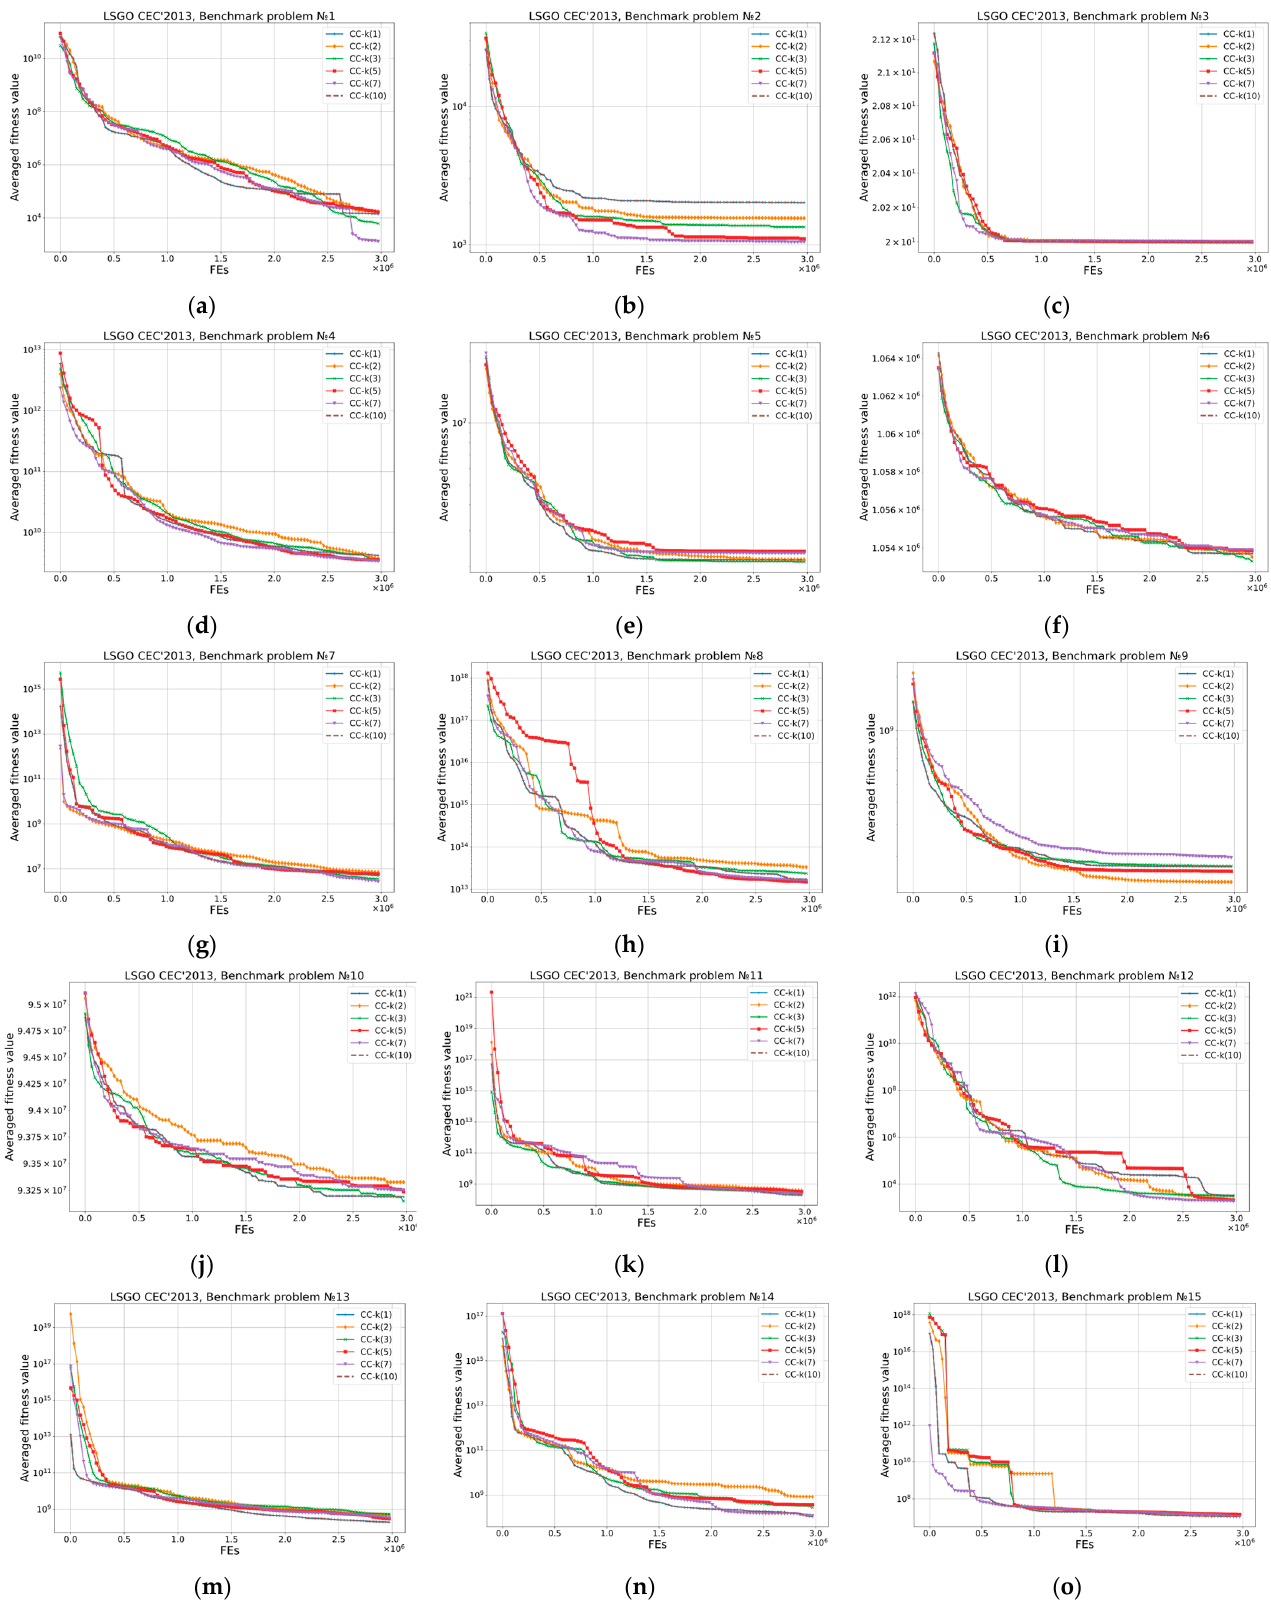
Figure 5. Convergence plots of CC-k algorithms. Benchmark problems are: ( a ) F 1 ; ( b ) F 2 ; ( c ) F 3 ; ( d ) F 4 ; ( e ) F 5 ; ( f ) F 6 ; ( g ) F 7 ; ( h ) F 8 , ( i ) F 9 ; ( j ) F 10 ; ( k ) F 11 ; ( l ) F 12 ; ( m ) F 13 ; ( n ) F 14 ; ( o ) F 15 .